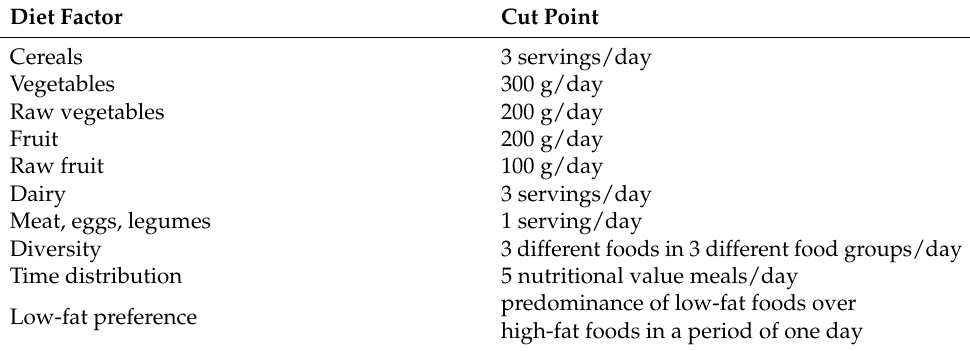
Table 1. Cut points of qualitative diet